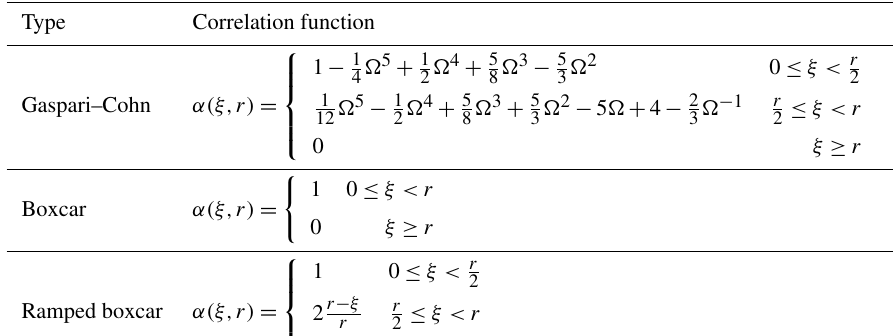
Table A1. Localization factor α for different correlation functions is given as function of the absolute distance between the observation gauge and the streamflow reaches, ξ , and the localization radius, r . The distance, ξ is computed along the river network and is equal to the sum of lengths of the reaches separating the observation gauge and the link that is subject to the update. The parameter (cid:127) , used in the Gaspari–Cohn . function, is defined as 2 ξ r